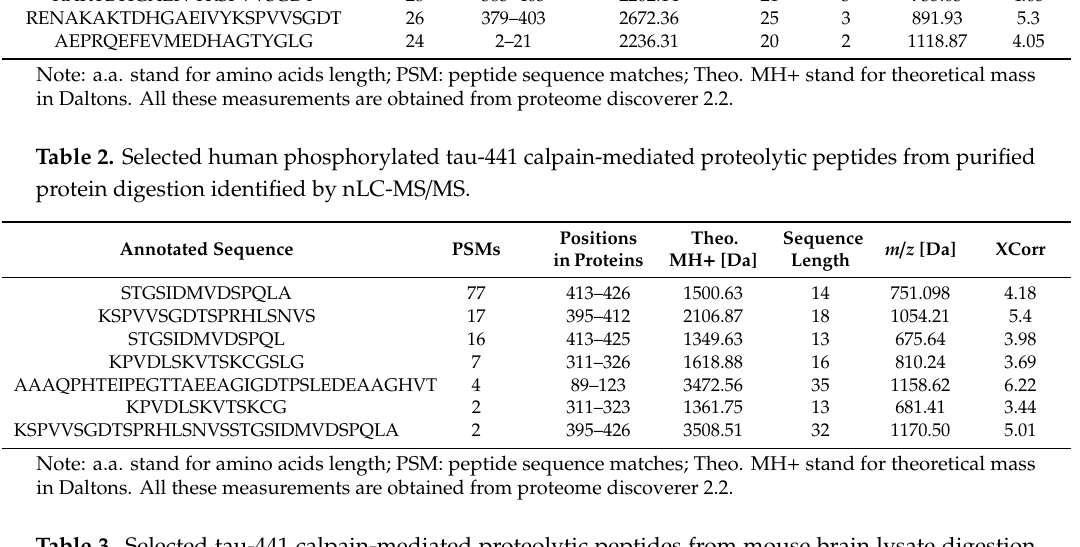
Table 3. Selected tau-441 calpain-mediated proteolytic peptides from mouse brain lysate digestion identified by nLC-MS / MS.